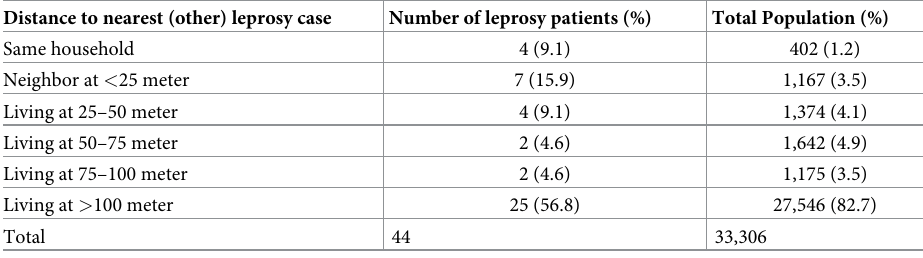
Table 1. Distribution of leprosy patients as a function of distance to nearest (other) leprosy patient. Distance to nearest (other) leprosy case